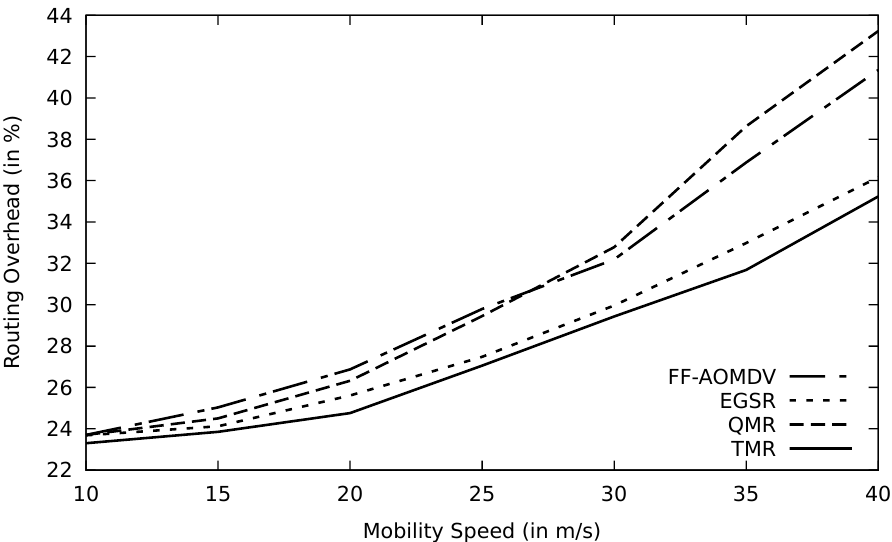
Figure 22. Comparison of FF-AOMDV, EGSR, QMR, and proposed protocol TMR for routing overhead with mobility speed.